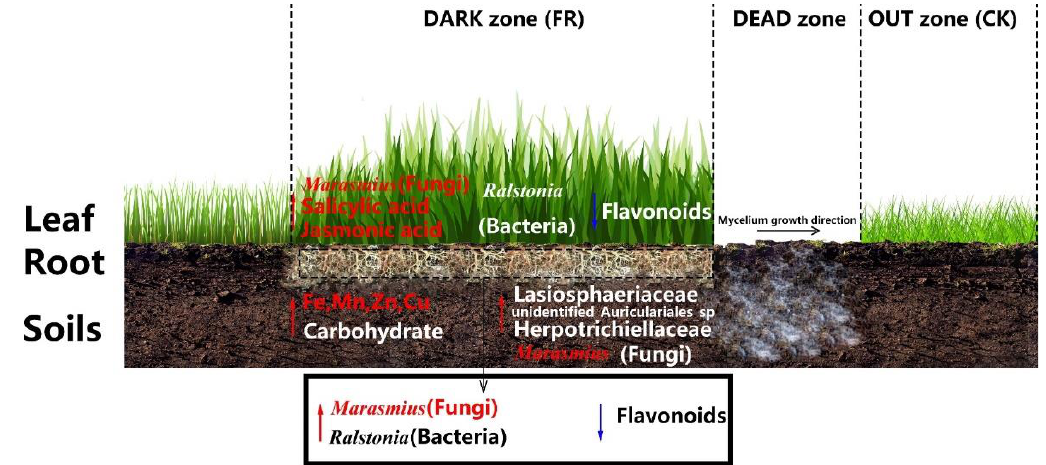
Figure 10. Proposed screening model showing the major factors influencing LC growth promotion in LM fairy rings. The red arrows represent upregulated factors, while the blue arrows represent downregulated factors. Red-labeled elements in the FR zone are important regulatory factors with known functions, and the white-labeled elements are the regulatory factors with unknown ecological functions.